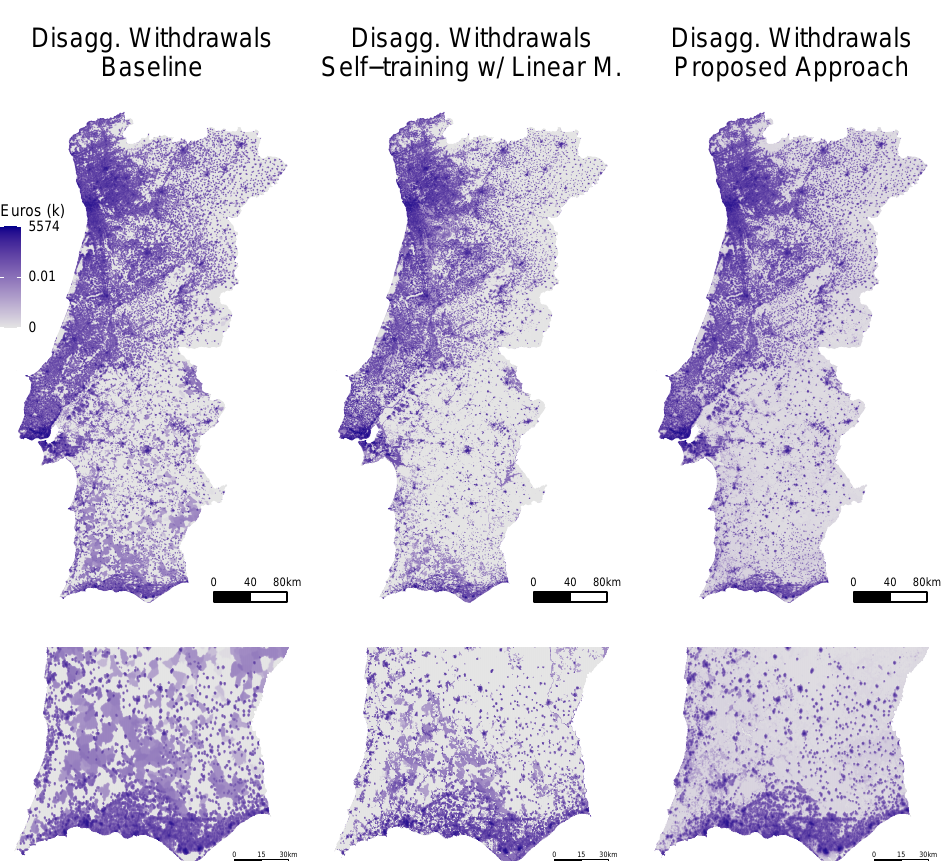
Figure 10. Spatially disaggregated results for the variable corresponding to the overall number of national